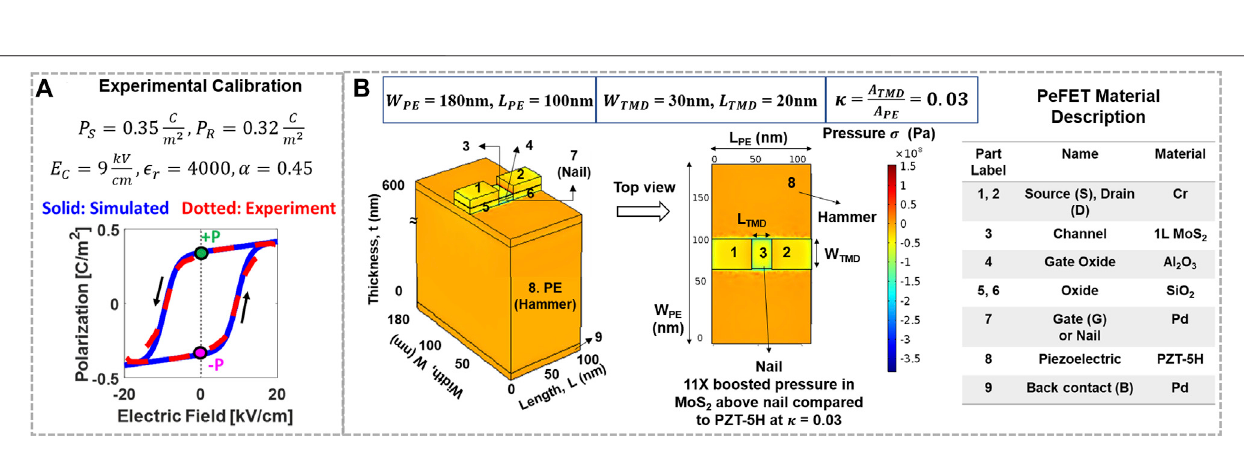
FIGURE 3 | HSPICE-compatible model of PeFET formed by integrating (i) Miller model of polarization – electrical fi eld behavior of PE, (ii) 3D COMSOL model of PeFETsimulatingpressureinPEanditstransductiontoTMDonapplicationofgatevoltage,and(iii)electrostaticsandtransportmodelofTMDaugmentedwithbandgap modulation behavior.